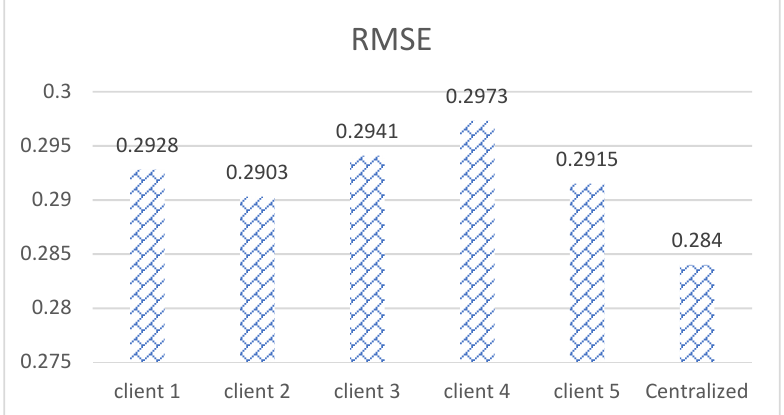
Figure 6. Comparison of average RMSE between different clients and centralized model.